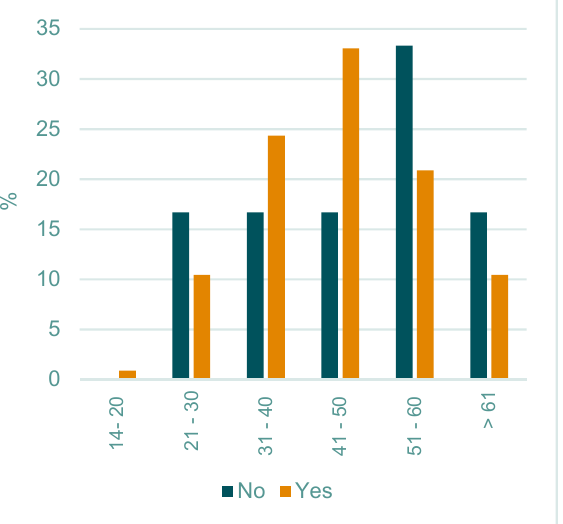
Figure 11. Response to the question ‘Given your sensitivity to the presented maps, are you willing to make changes to your neighborhood?’, by age group.